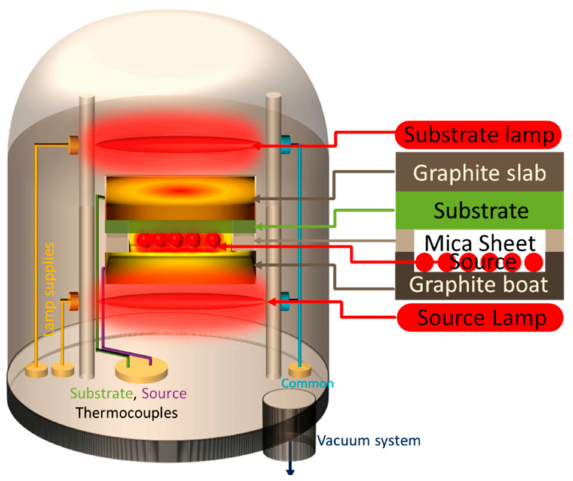
Figure 1. Schematic of Close Spaced Sublimation (CSS) technique used for deposition of ZnTe thin